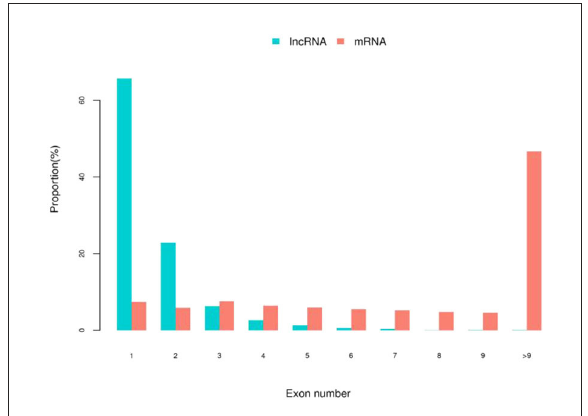
FIGURE3 The statistics of lncRNA and mRNA exons number in embryonic hair follicles of Inner Mongolia cashmere goats. The blue column represents the number of lncRNA exons, and the red column represents the number of mRNA exons.